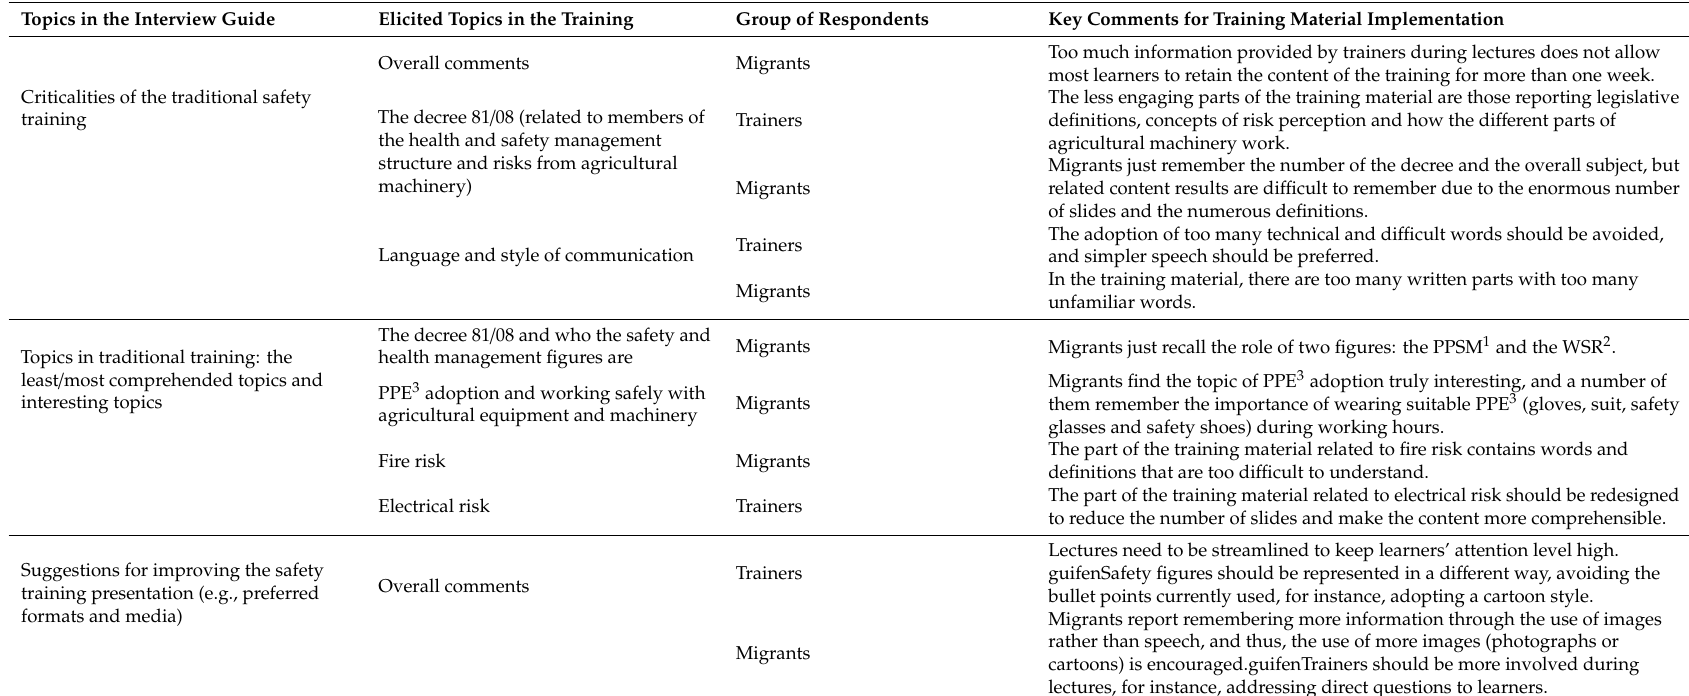
Table 1. Main comments of trainers and migrant